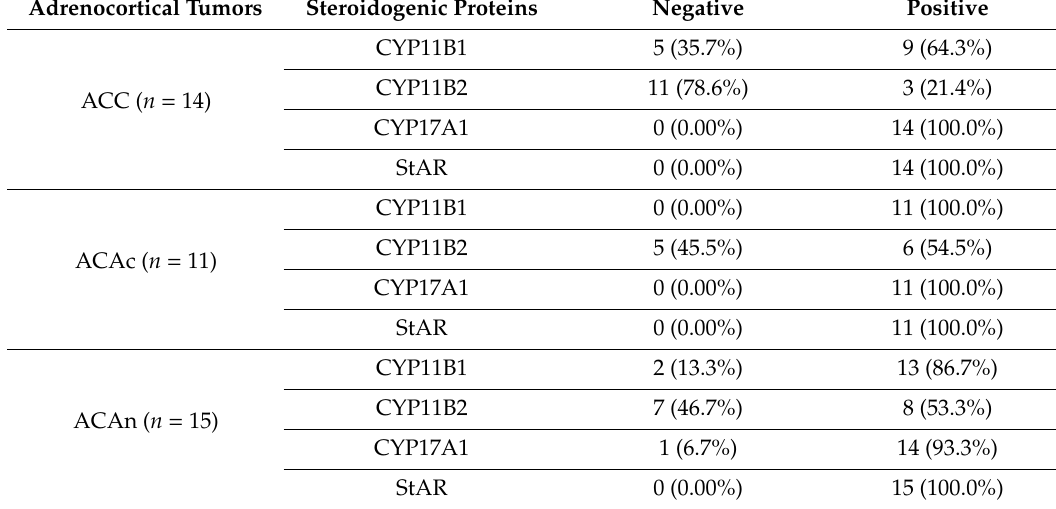
Table 1. Frequency of CYP11B1, CYP11B2, CYP17A1 and StAR immunostaining positivity in the different adrenocortical tumors.